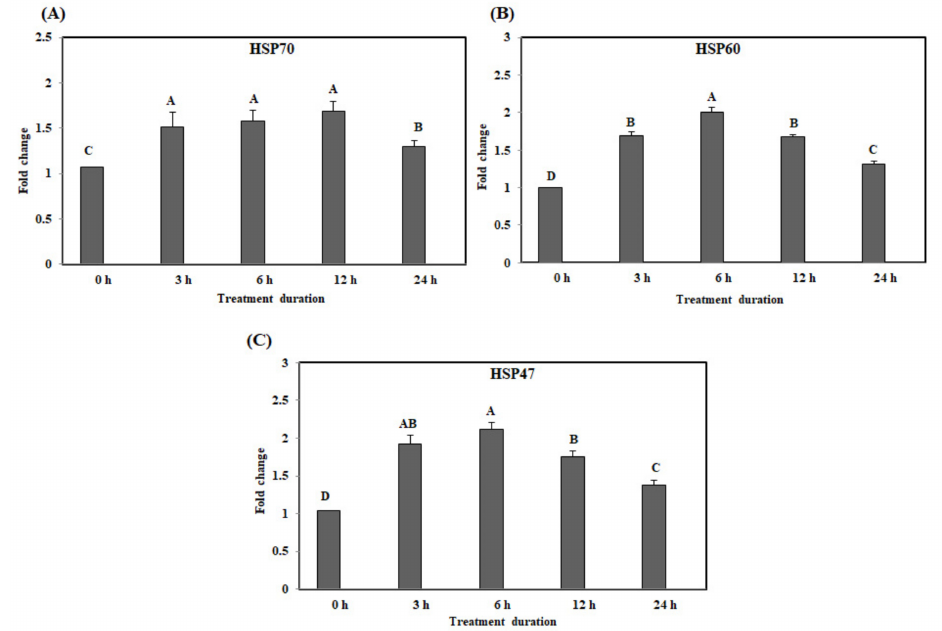
Figure 3. The mRNA expression of the heat shock proteins in the ileum of chickens exposed to acute heat stress for di ff erent durations of time ( n = 8). The mean relative expression of HSP70 ( A ), HSP60 ( B ), and HSP47 ( C ). A–D HSP70 , HSP60 , and HSP47 in the columns with di ff erent superscript letters di ff er significantly ( p < 0.05) among the di ff erent heat exposure